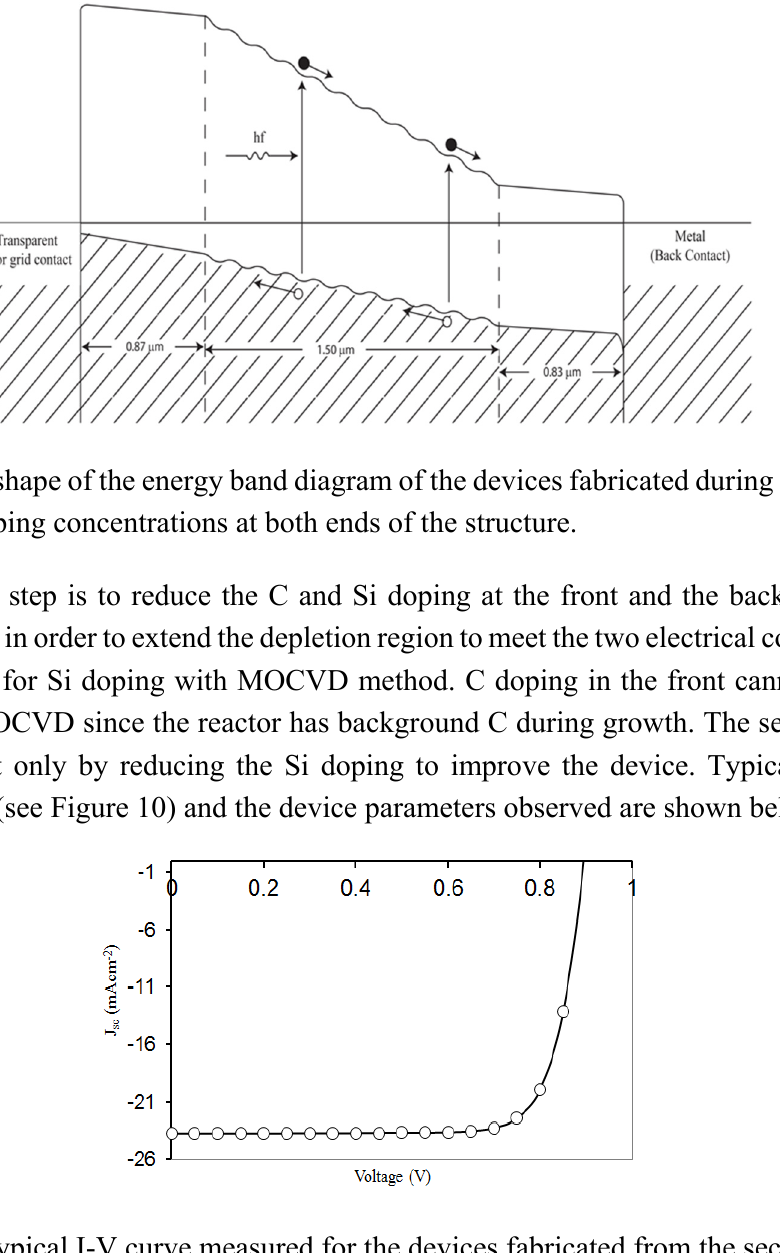
Figure 10. A typical I-V curve measured for the devices fabricated from the second growth after adjusting Si doping to ~10 15 cm − 3